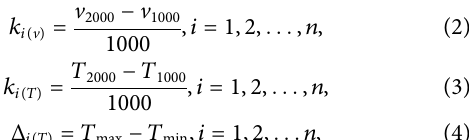
FIGURE 5 | Complete TCN